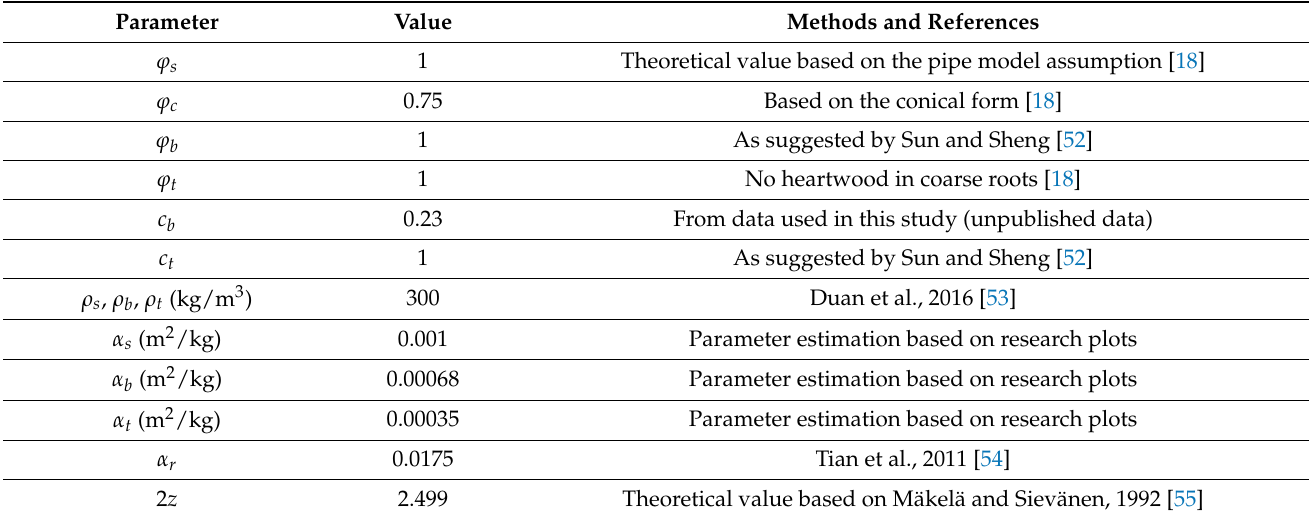
Table A1. Localization parameters of the CROBAS-CL